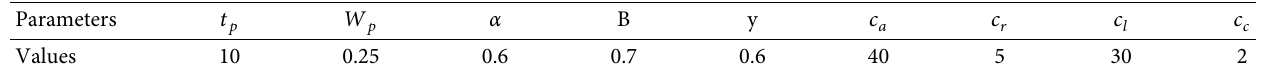
Table 3: The values of parameters.